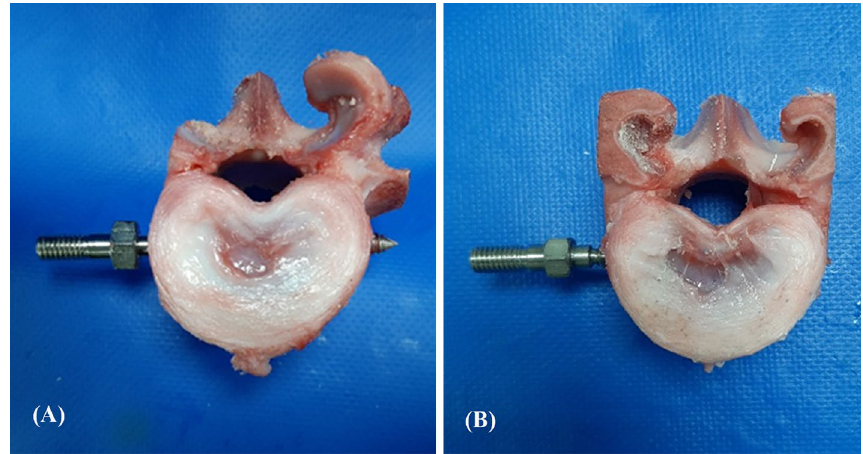
Figure 1. Photographs showing the axial view of the porcine vertebrae with bicortical and unicortical fixation. ( A ) At least 2 thread widths penetrated out of the opposite cortex in the bicortical fixation modality; and ( B ) no penetration was observed in the unicortical fixation modality.